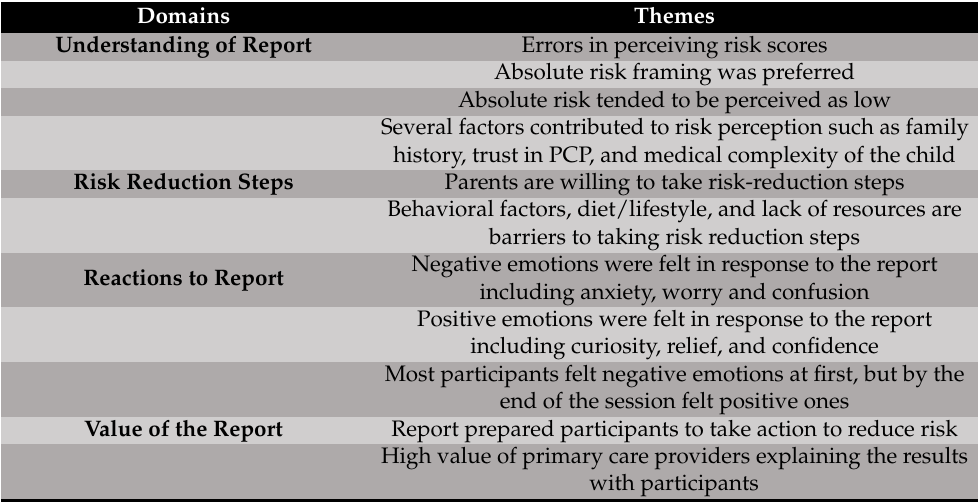
Table 2. Domains and